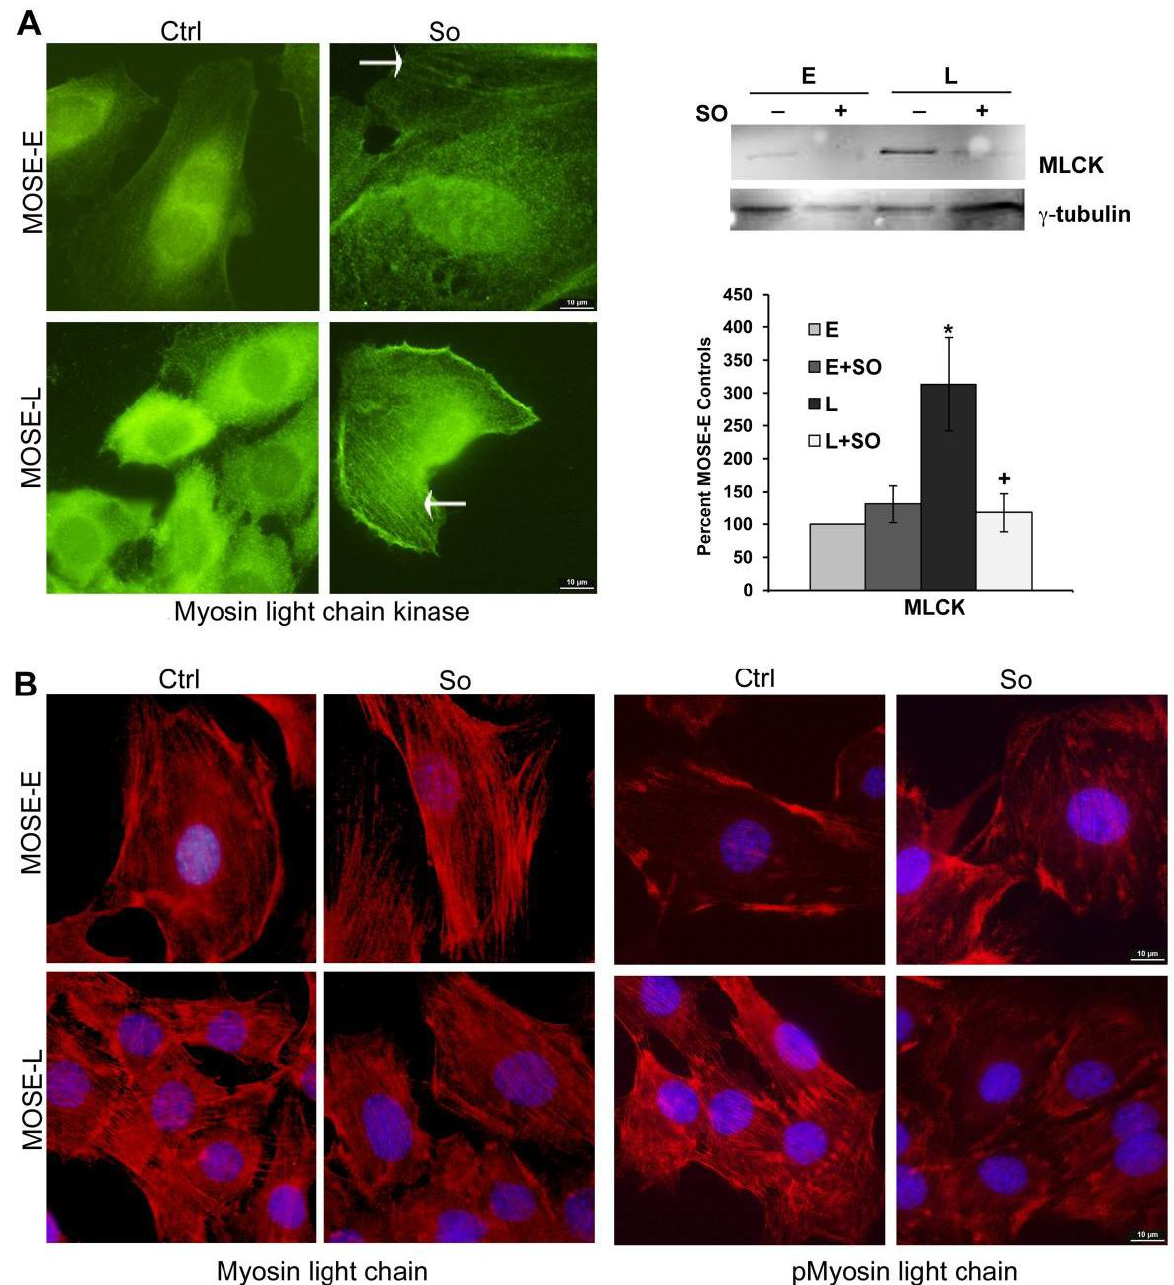
Figure 5. Changes in MLCK expression and its target phosphorylation after Sph treatment. (A) Immunofluorescent identification of myosin light chain kinase (MLCK); arrow indicates co-localization with F-actin (left panel); Western blot analysis and quantitation of MLCK in whole cell extracts, normalized to  tubulin. A representative blot is shown in the right panel. Data are expressed as percent of MOSE-E  SEM; *significantly different from MOSE-E, p  0.05; +significantly different from corresponding untreated control, p  0.05. (B) Myosin light chain expression (left panels) or myosin light chain phosphorylated at Ser-19 (pMyosin light